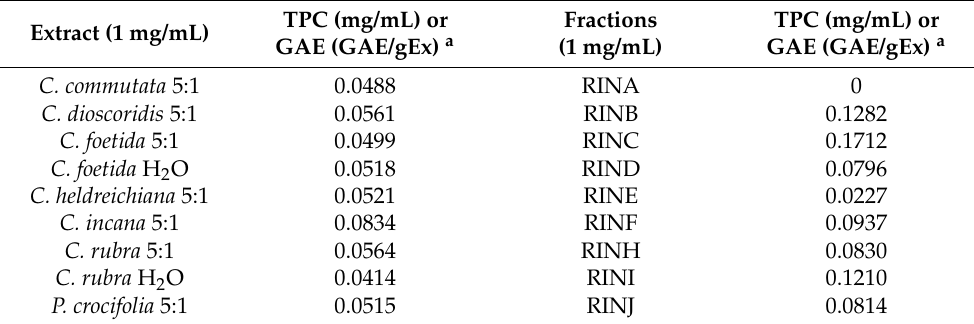
Table 2. Total polyphenol content (TPC) of plant extracts, fractions and reference compounds, expressed as TPC or GAE values (F-C